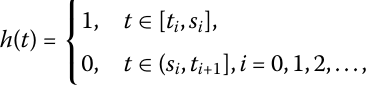
Figure 1(a) shows that networks (27) are unstable. The controller Σ h ( t ) x ( t – τ )d B ( t ) is designed. That